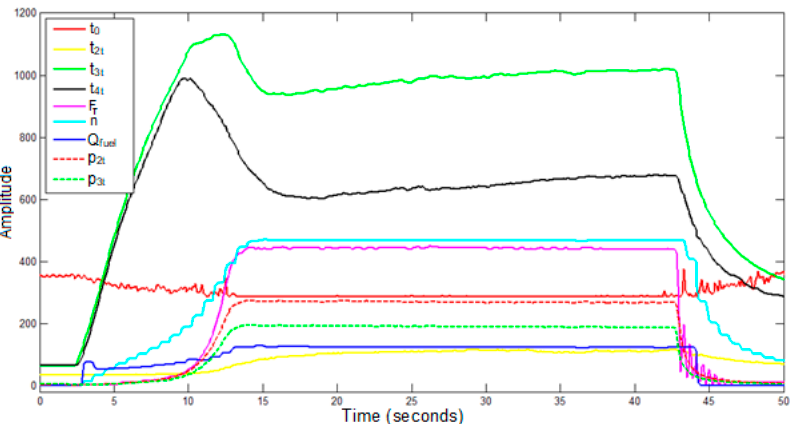
Figure 5. Graphic course of changes in SJE-20 parameters when using a mixture of 90% Jet A-1 aviation kerosene and 10% FAME biofuel.